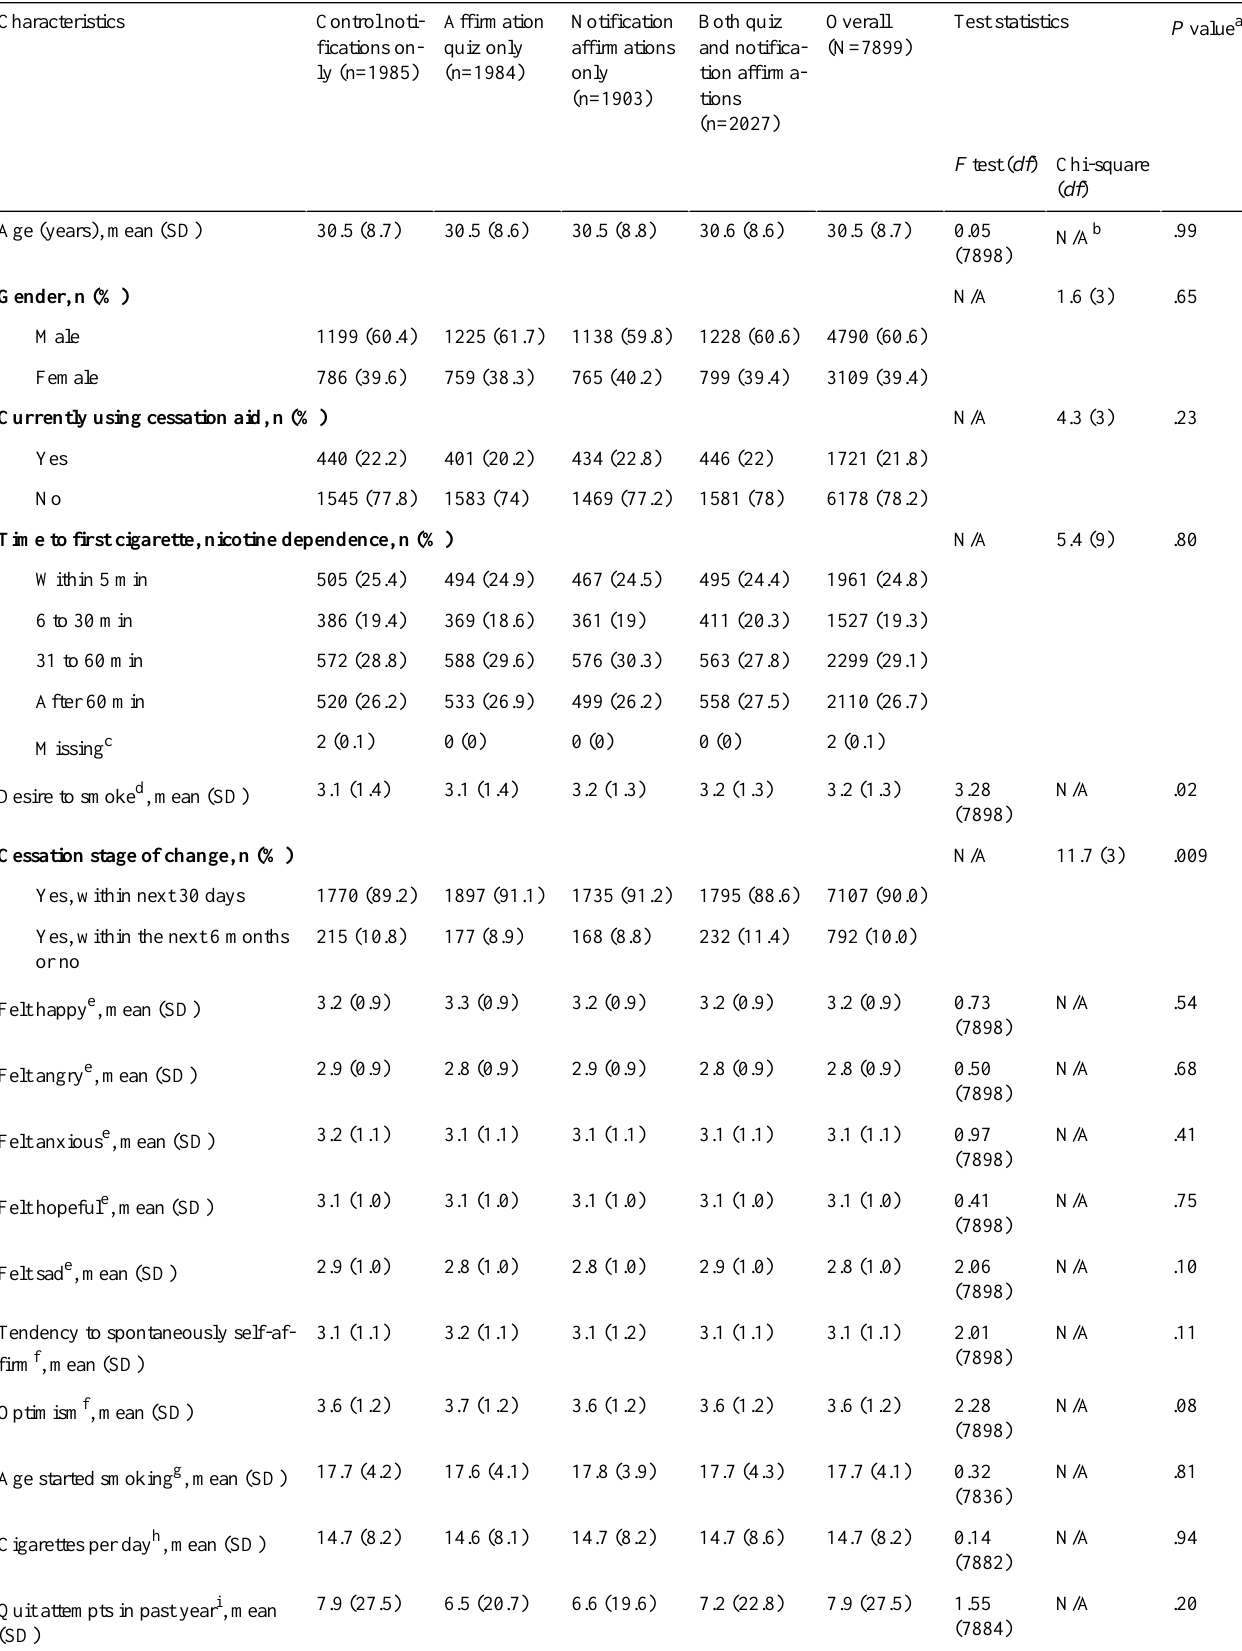
Table 1. Baseline characteristics of the study participants (N=7899).